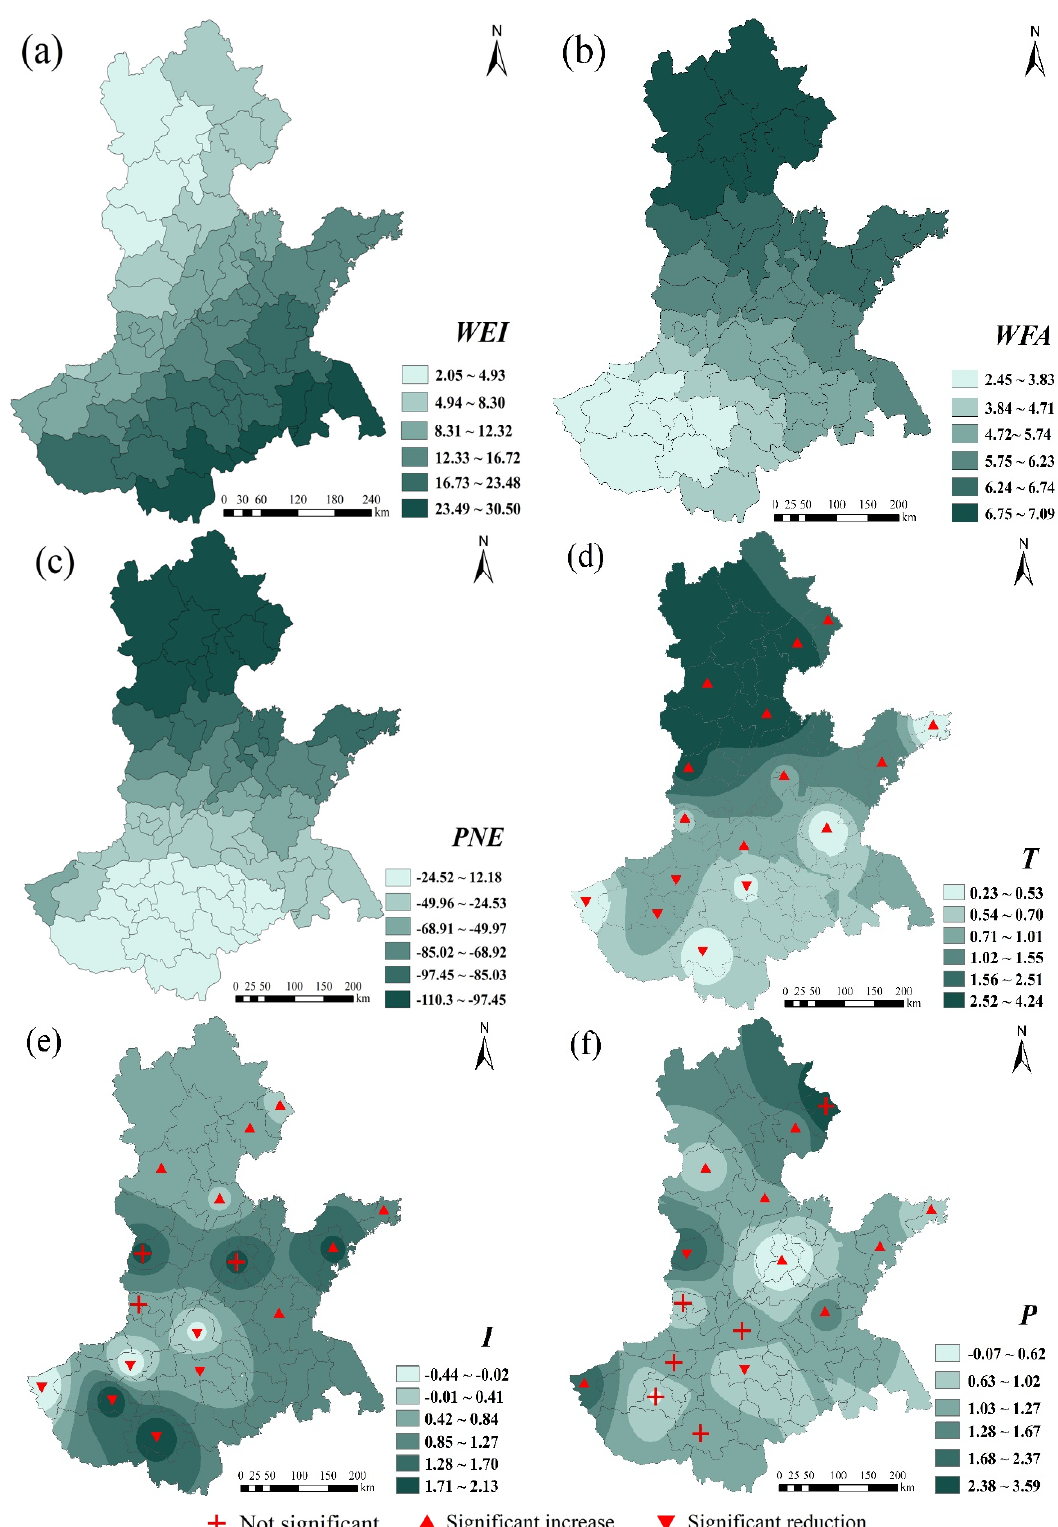
Figure 10. Spatial distribution of the regression coefficients for the SCA-GWR model in 2010: ( a ) WEI ; ( b ) WFA ; ( c ) PNE ; ( d ) T ; ( e ) I ; ( f ): P .